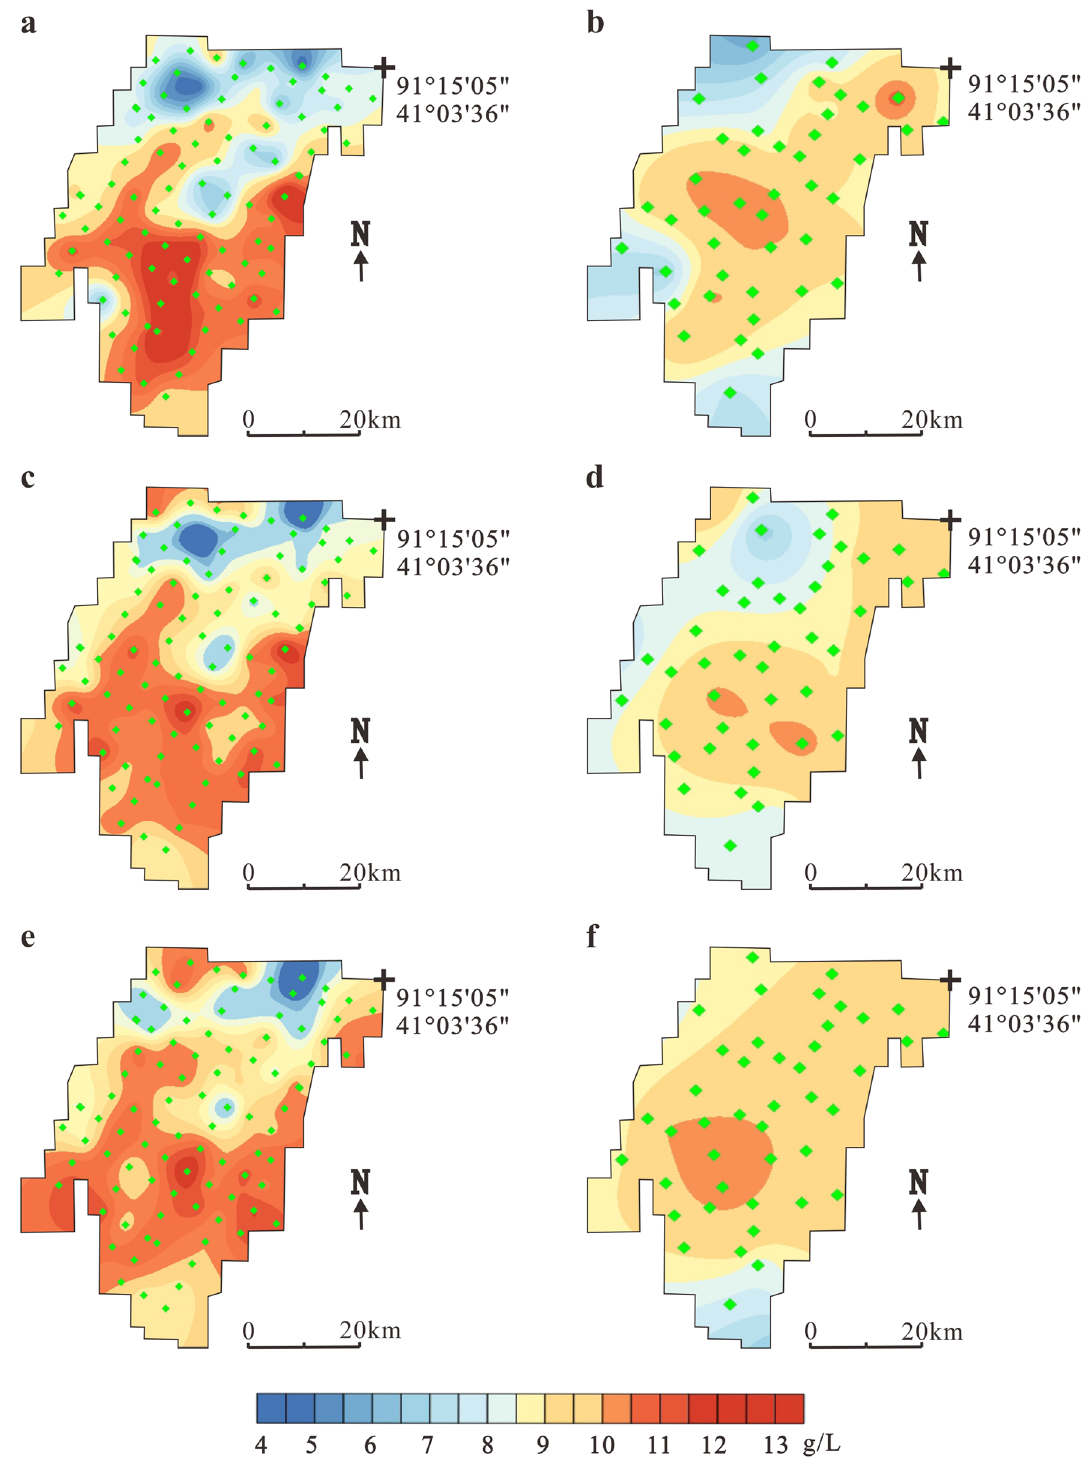
Figure 4. Temporal and spatial variations in K + content of different brine layers in Luobei depression. ( a ) Layer W 1 in 2006, ( b ) Layer W 1 in 2017, ( c ) Layer W 2 in 2006, ( d ) Layer W 2 in 2017, ( e ) Layer W 3 in 2006 and ( f ) Layer W 3 in 2017. The green dots indicate observation holes